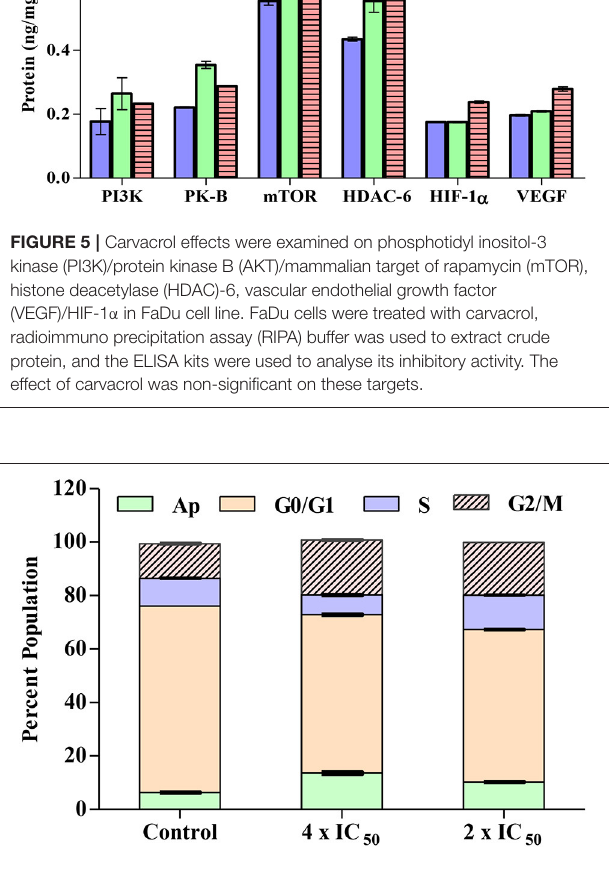
cells (49), gastric carcinoma cells (50), leiomyosarcoma cells